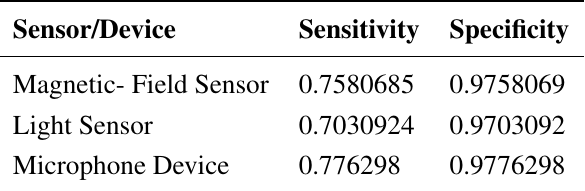
Table 3. Comparison of sensitivity and specificity: winter dataset.